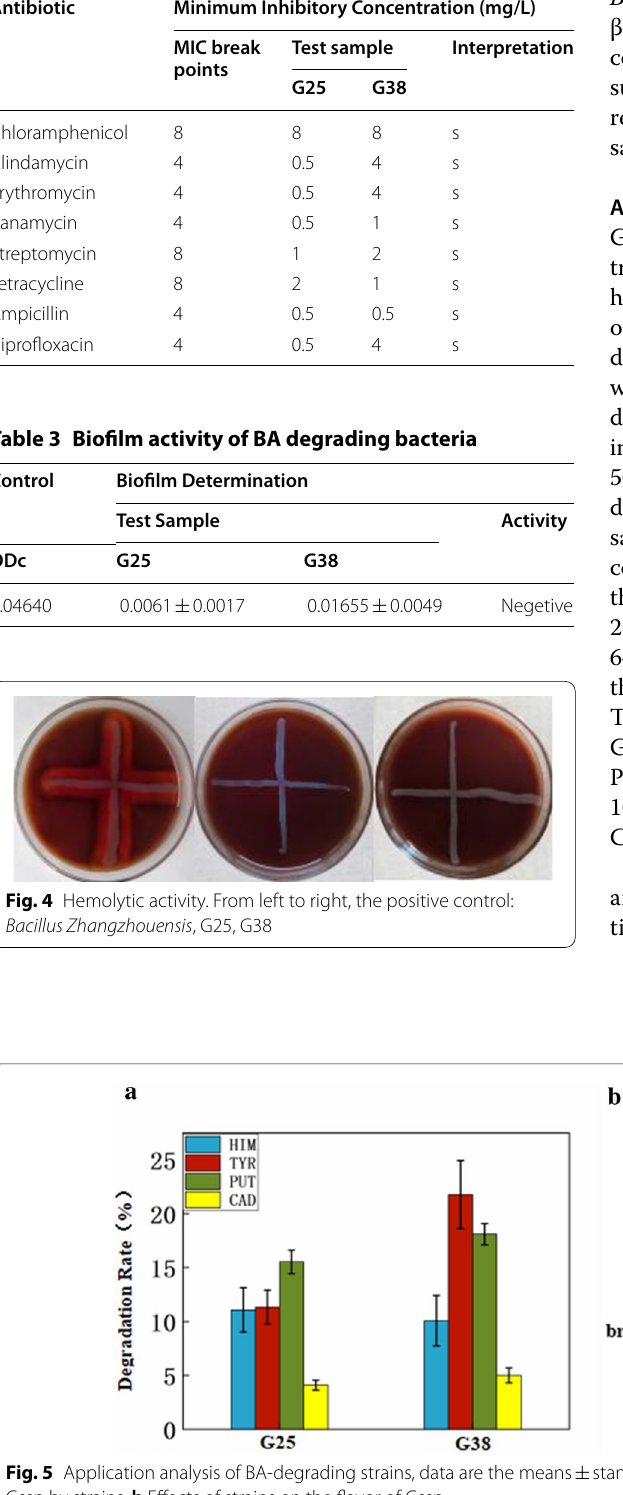
Fig. 5 Application analysis of BA-degrading strains, data are the means Gssp by strains. b Effects of strains on the flavor of